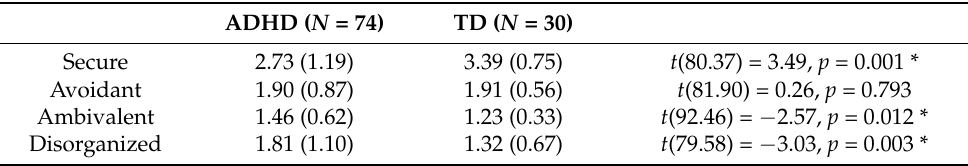
Table 2. Attachment representations of children with and without